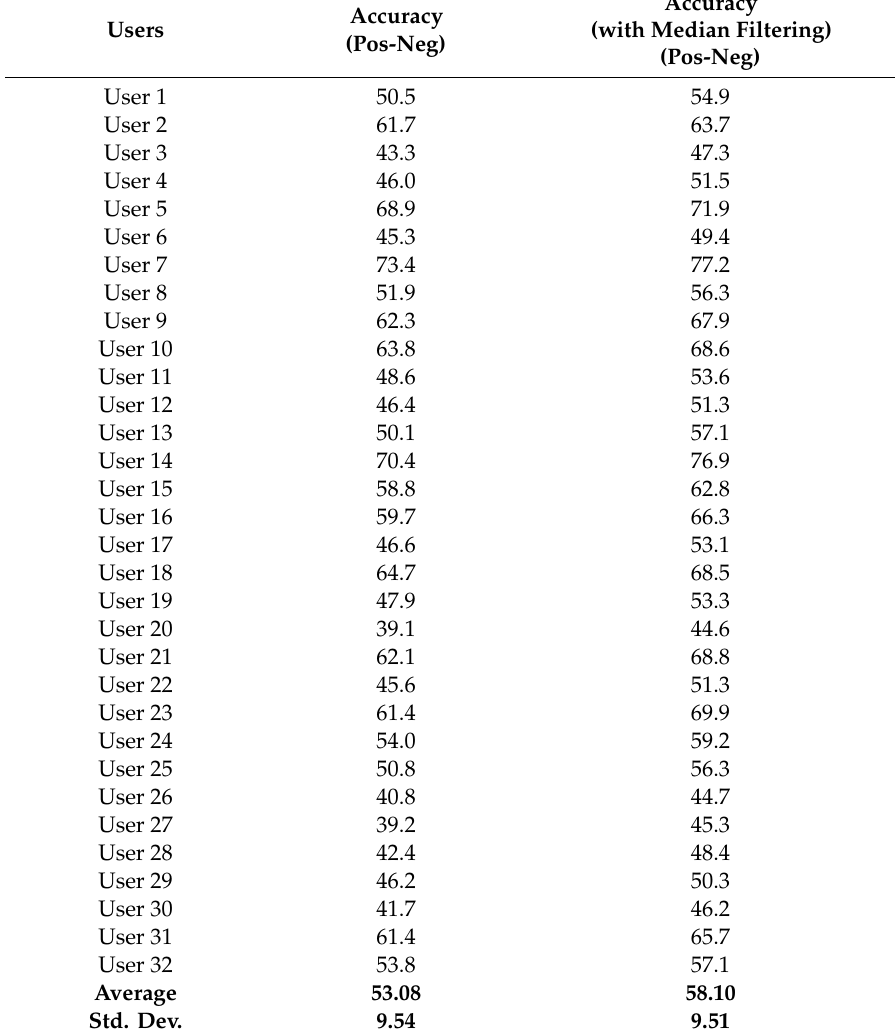
Table 8. Cross-dataset prediction accuracy results (Trained on SEED and Tested on